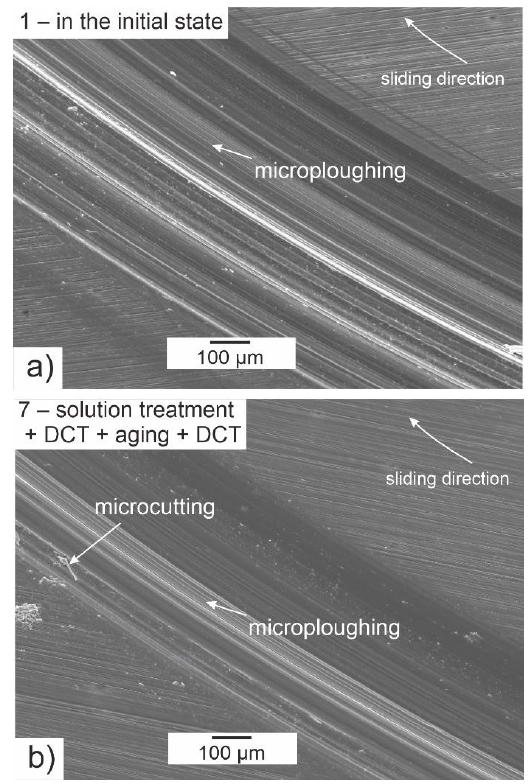
Figure 14. SEM images after tribological tests in rotational motion of the Mg-Y-Nd alloy in the as-delivered condition ( a ) and after heat treatment combined with DCT ( b ).